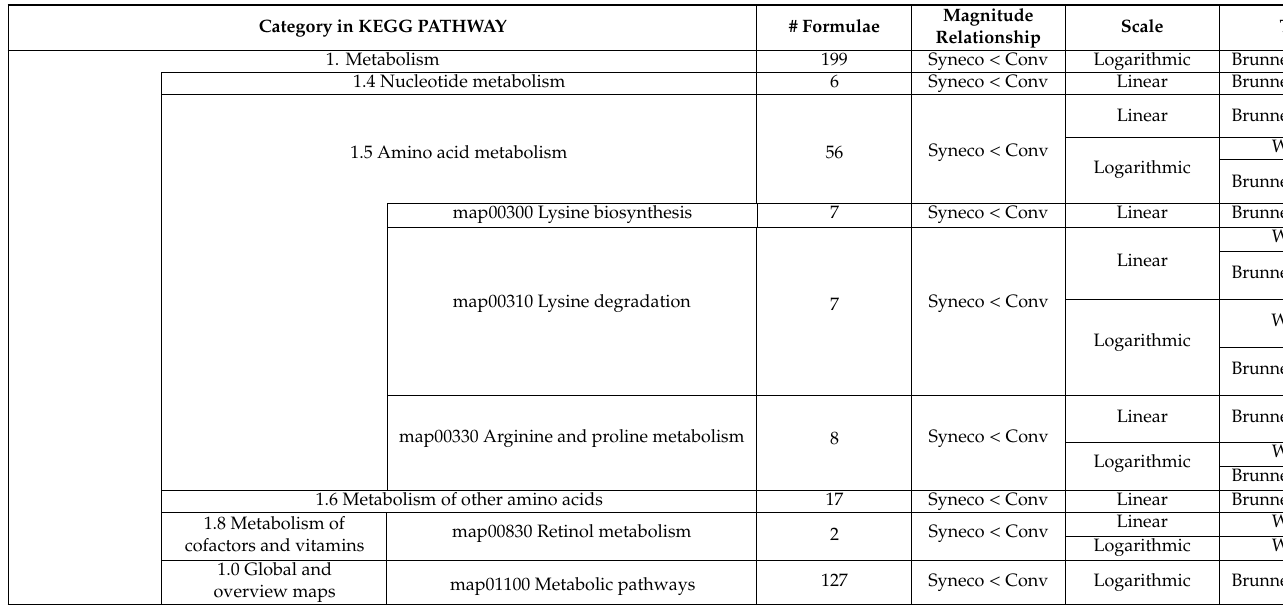
Table 4. Results of KEGG PATHWAY category-wise tests with p < 0.05: The di ff erence of intensity in each KEGG PATHWAY category (column “Category in KEGG PATHWAY”) is tested with two-sided Welch’s t -test and Brunner-Munzel test (“Test”). The signs of p -values (in “ p -Value”) represent the magnitude relationship of mean intensity between Syneco and Conv (“Magnitude Relationship”); negative sign means Conv was greater than Syneco, and positive sign means Syneco was greater than Conv. The column “Scale” indicates whether the intensity was used in linear or logarithmic scale for the tests. The intensity value was used both as chemical formula-wise aggregated mean and as separated intensity peaks (indicated as Formula and NA, respectively, in the column “Averaging”). The column “# Formulae” represents the number of chemical formulae estimated in each